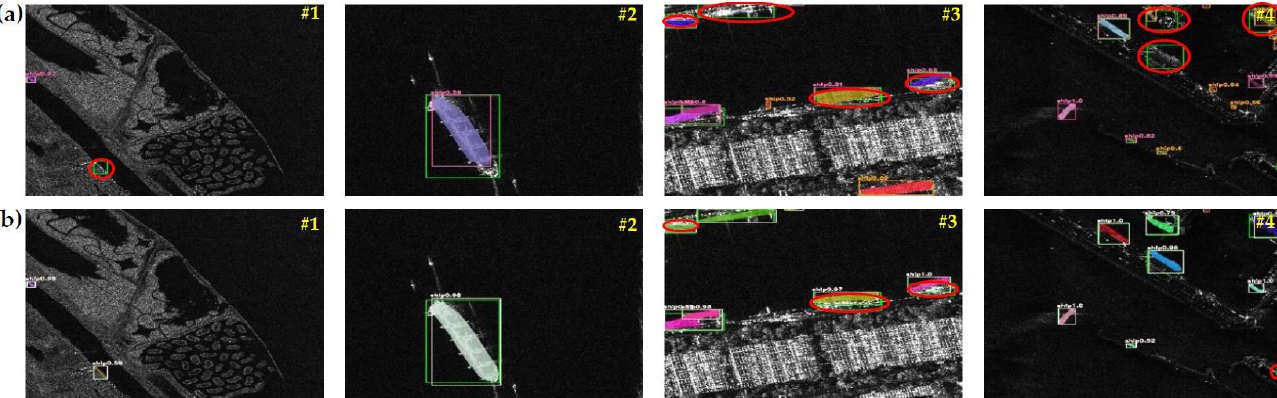
Figure 16. Qualitative results on SSDD. ( a ) PANet with the second-best mask AP. ( b ) GCBANet. Green boxes denote the ground truths. Orange boxes denote the false alarms (i.e., false positives, FP). Red circles denote the missed detections (i.e., false negatives, FN). #i denote the ith picture of results.